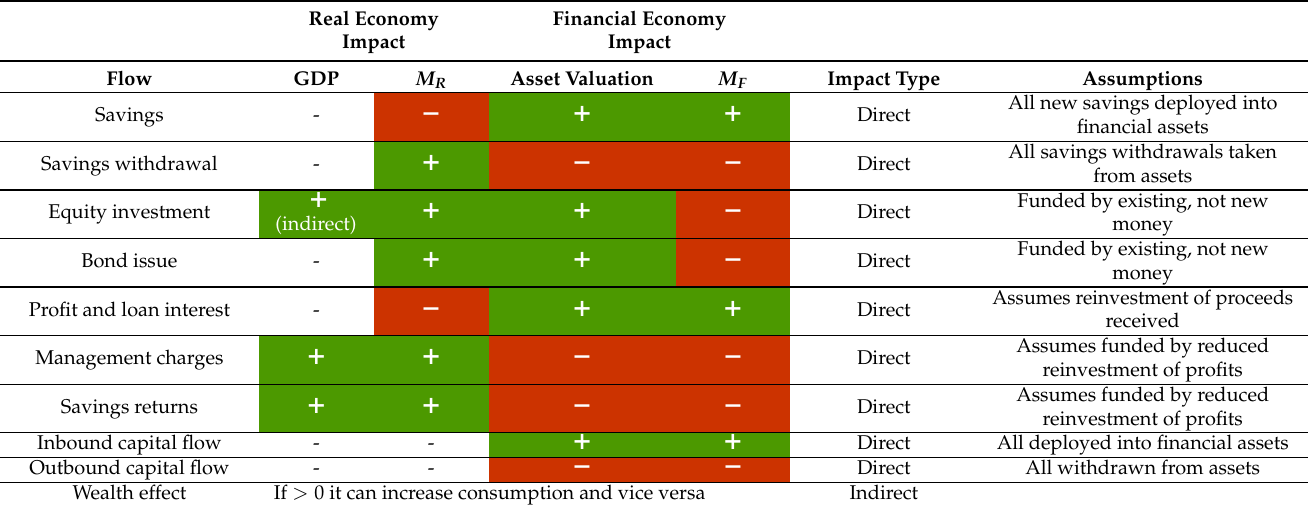
Table 4. Impacts of monetary flows on real and financial